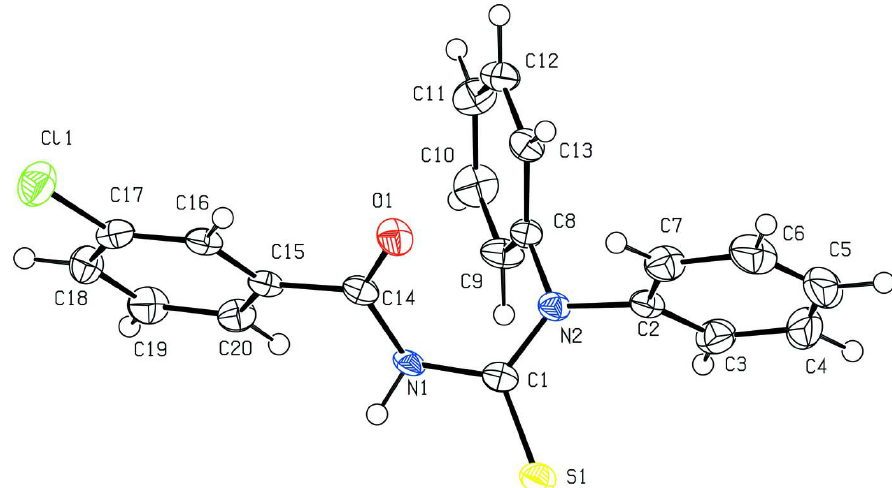
Figure 1 The molecular structure of (I). Displacement ellipsoids are drawn at the 50% probability level.